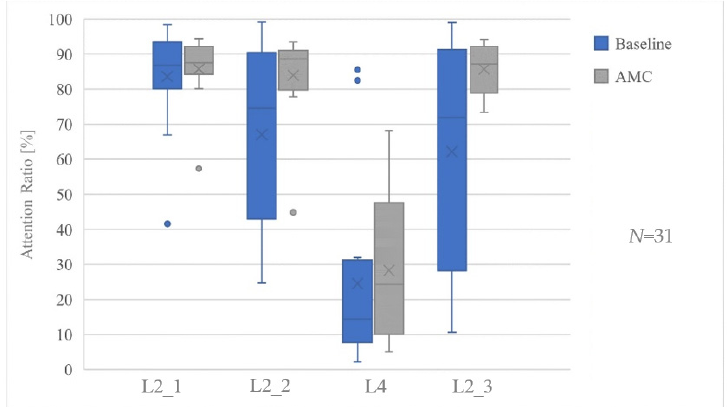
Figure 6. Boxplots for the road ahead attention ratio for different segments and divided by HMI condition. The L4 phase is displayed but not included in the statistical evaluation. The x represents the mean value.